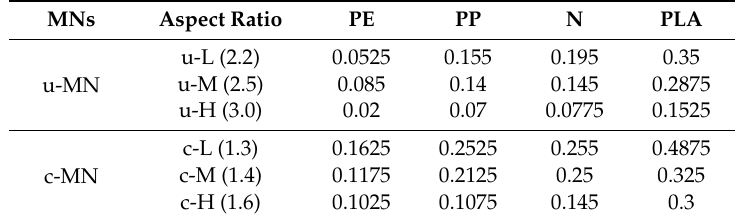
Table 4. Initial slope of force displacement of MNs before and after coating formulation with respect to kind of polymer (PE, PP, nylon and PLA) and aspect ratio. MNs Aspect Ratio PE PP N PLA u-L u-MN